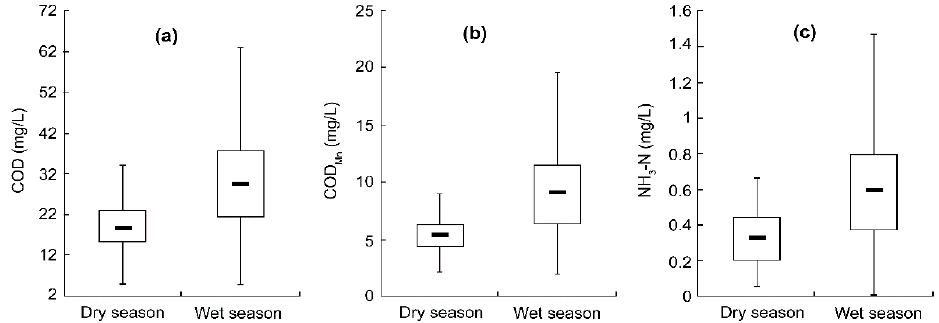
Figure 7. Range of background values for different variables in the dry and wet seasons: ( a ) COD, ( b ) COD Mn , and ( c ) NH 3 -N.